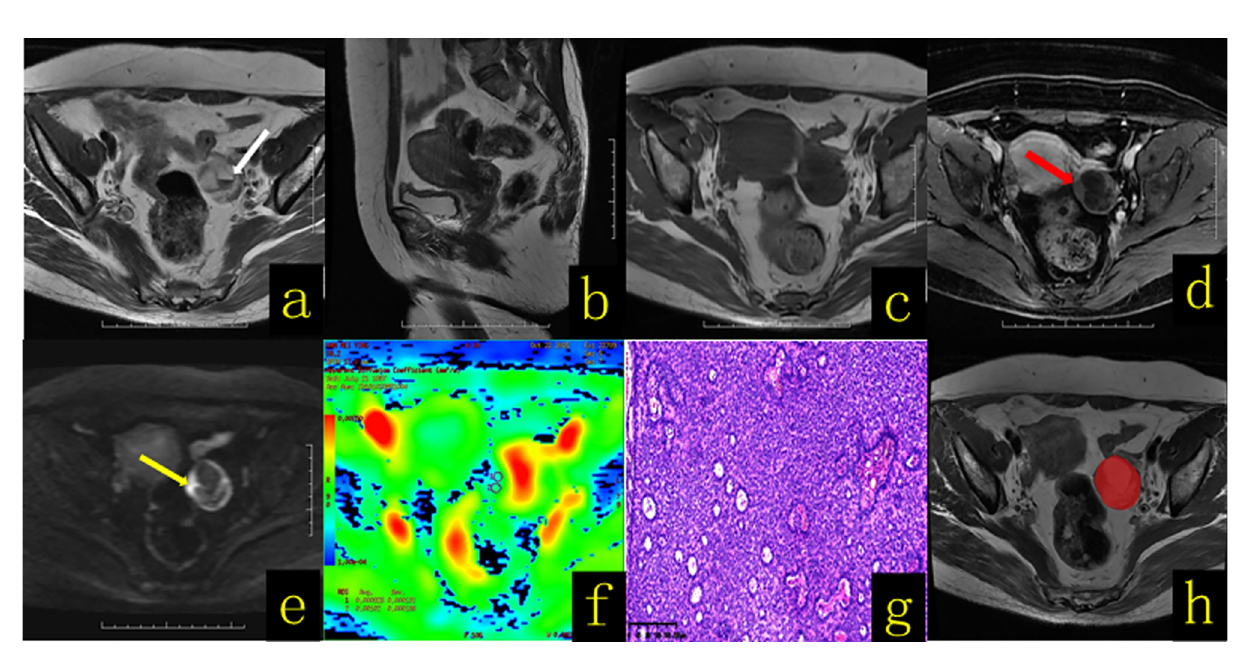
FIGURE 2 | A 58-year-old female patient with an ovarian granulosa cell tumor. (A) Axial T2WI revealed a well-de fi ned cystic solid mass in the left adnexal region, with fl uid – fl uid levels (hemorrhagic content, white arrow). (B) Sagittal T2WI showed no thickening of the endometrium. (C) Axial T1WI revealed a cystic solid mass with a hypo – isointense signal. (D) On contrast-enhanced fat-suppressed T1WI, the solid components (red arrow) of the lesion showed mild enhancement. (E) On DWI-MRI ( b = 1,000 s/mm 2 ), the solid part of the lesion (yellow arrow) appeared hyperintense. (F) The apparent diffusion coef fi cient (ADC) map showed that the average ADC value of the diffuse high-signal area was approximately 1.1 × 10 -3 mm 2 /s. (G) Hematoxylin and eosin (H&E) staining (×100) showed that the tumor cells were solid tubular structures, and the tubules were composed of uniform cells containing Call – Exner bodies. (H) The texture analysis target area was delineated throughout the whole tumor layer by